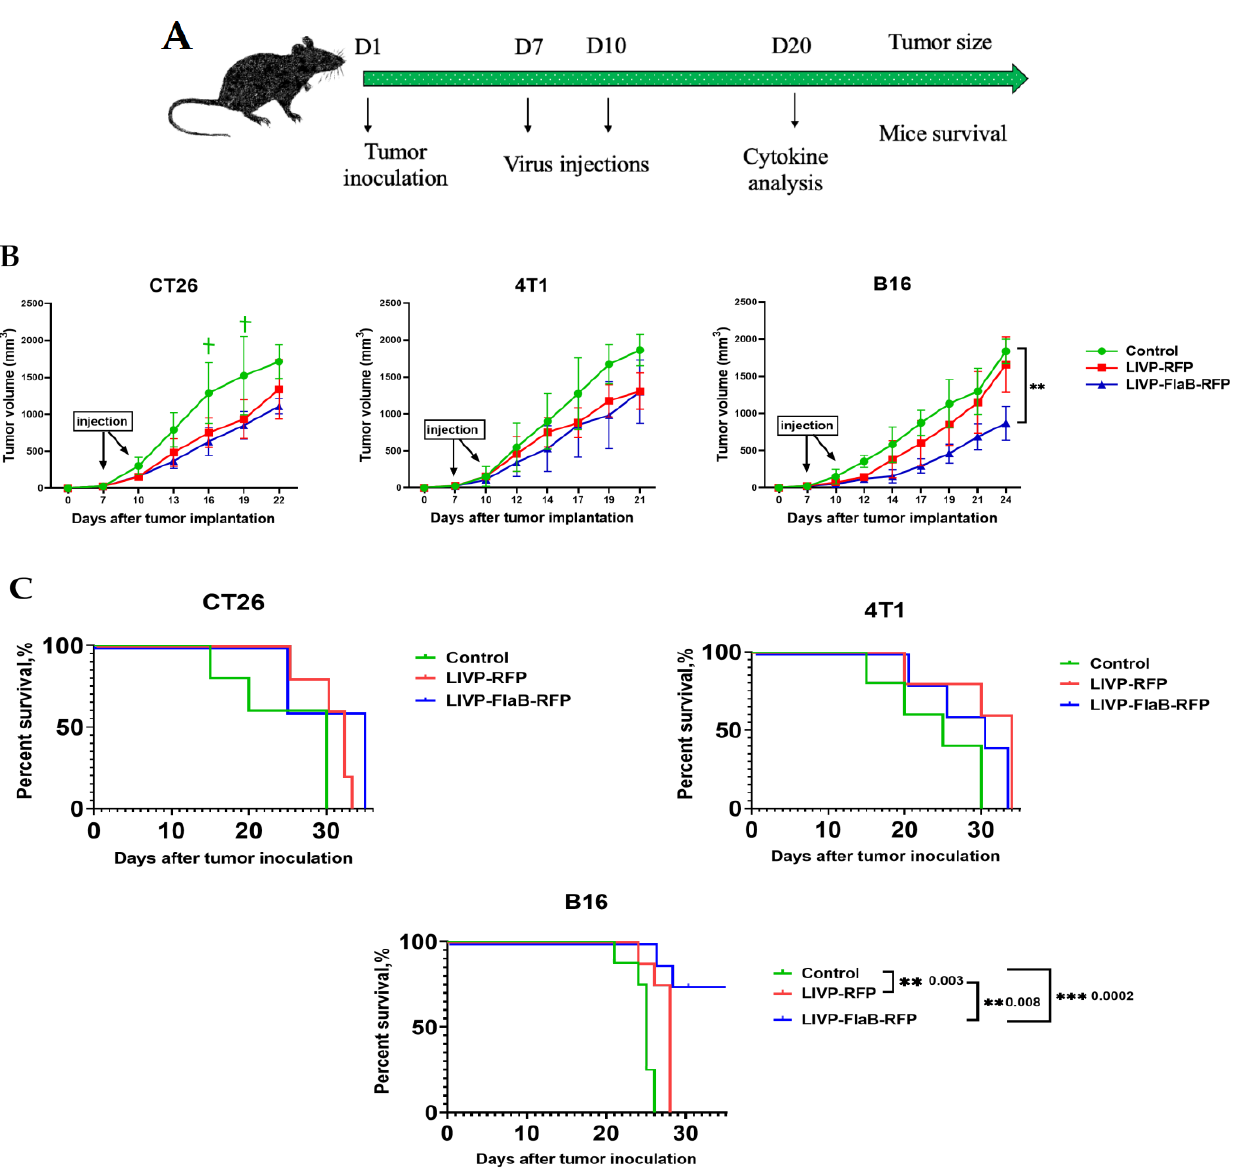
Figure 7. Virotherapy. ( A ) Schematic of the treatment protocol mice ( n = 11) were injected subcu- taneously with B16, CT26, or 4T1 cells on day 1. Seven days after tumor inoculation, viruses were injected intravenously. Then, the mice received a booster shot on day 10. Ten days after treatment, three mice from each group were sacrificed to obtain sera and tumor samples for cytokine analysis. ( B ) Tumor progression (B16, 4T1, CT26) in treated groups with LIVP-RFP or LIVP-FlaB-RFP com- pared to the control groups. The symbol ✝ indicates the animal’s sacrifice in control groups. ( C ) Overall survival percentages of treated and control mice based on the Kaplan–Meier method. For statistical analysis, ANOVA and survival analysis were performed; ** p < 0.01 and *** p < 0.001 indicate significance.